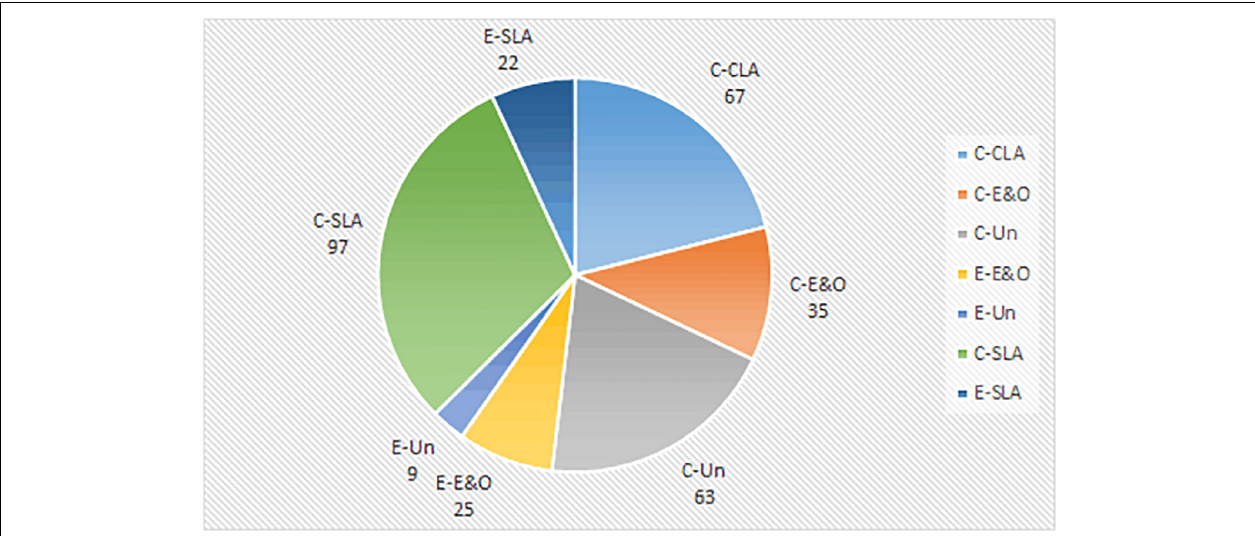
FIGURE 6 | Citation trends (1999–2020). C-CLA, Chinese language publications on CSL/CFL anxiety research; C-E&O, Chinese language publications on English or other language anxiety research; C-SLA, Chinese language publications on SLA; C-Un, Chinese language publications unrelated to FLA or SLA; E-CLA, English language publications on CSL/CFL anxiety research; E-E&O, English language publications on English or other language anxiety research; E-SLA, English language publications on SLA; E-Un, English language publications unrelated to FLA or SLA.